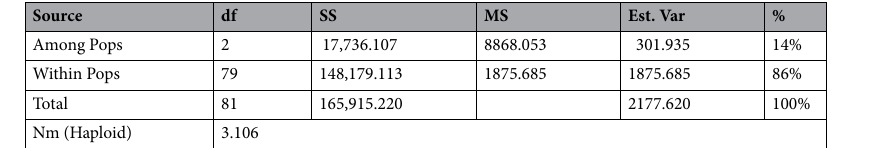
Table 2. Analysis of molecular variance (AMOVA) using 10,019 SNPs of the genetic variation among and within the subpopulations of 82 wheat accessions.